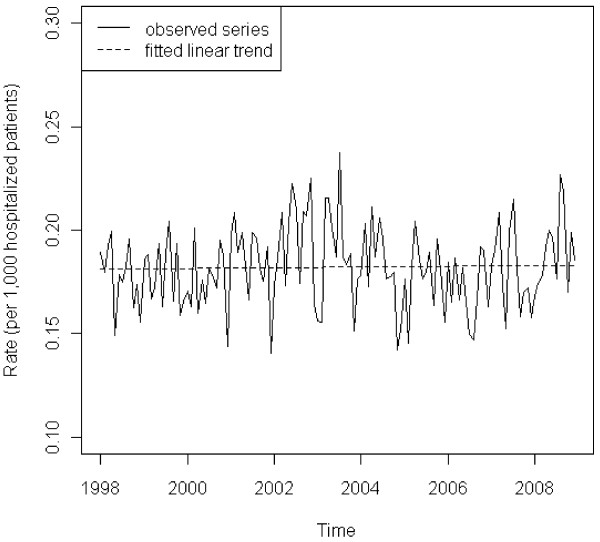
Monthly incidence rates of hospitalization due to a primary diagnosis of sarcoidosis (Nationwide Inpatient Sample, 1998–2008). The solid line represents the observed rate over time. The dashed line is the fitted linear trend (p = 0.7259)